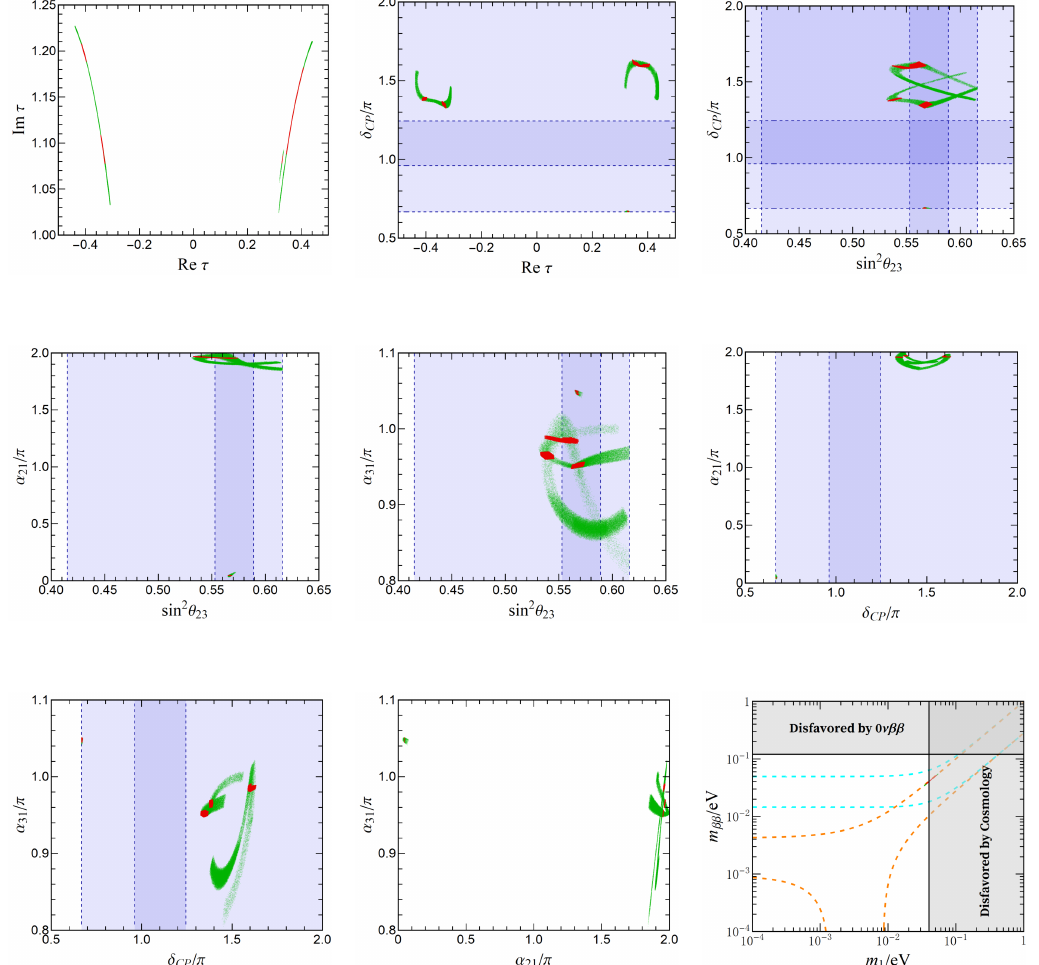
Figure 2 . The correlations between the neutrino parameters predicted in the example model of type IV. We adopt the same convention as figure